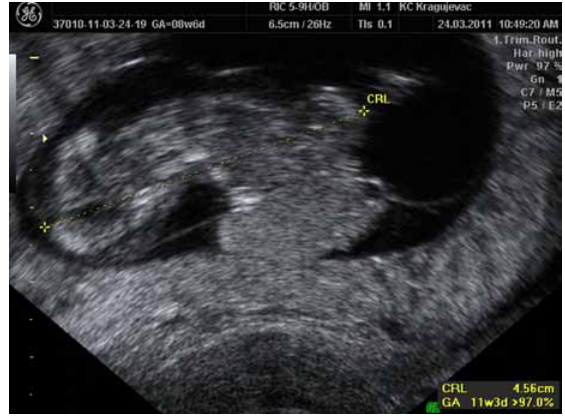
Figure 1. Ultrasonography of giant fetal omphalocela in 11 week of